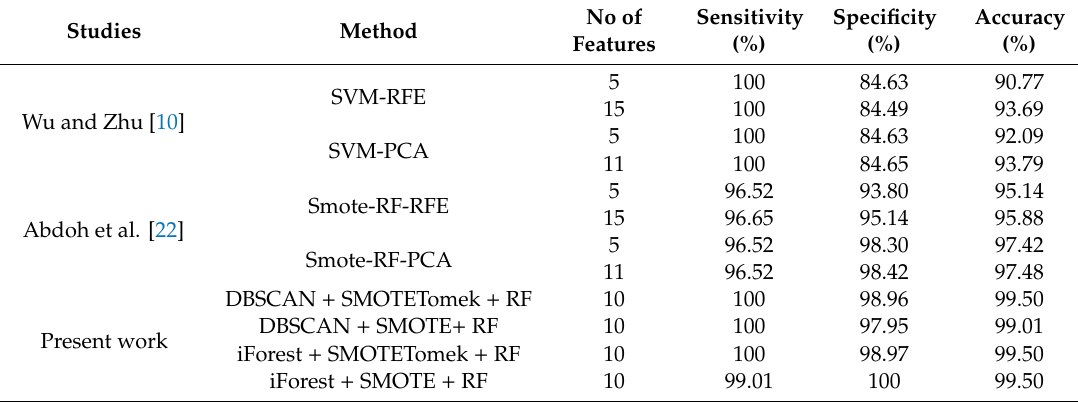
Table 24. Comparison of Hinselmann test results of CCPM with past studies.